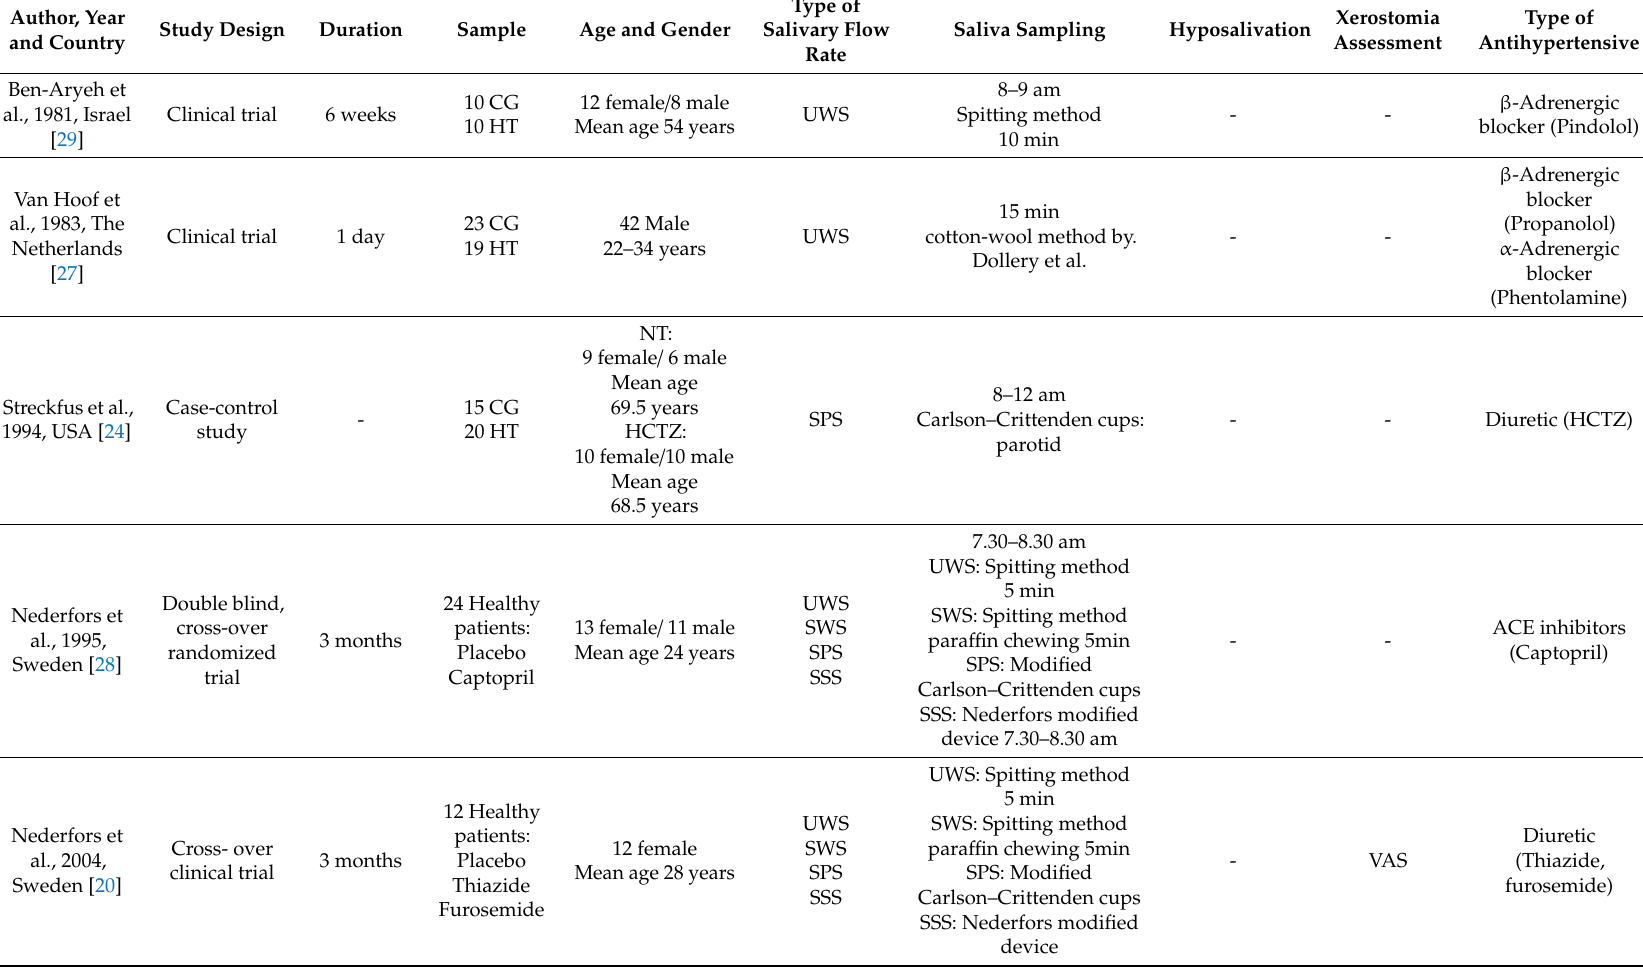
Table 1. General characteristics of the